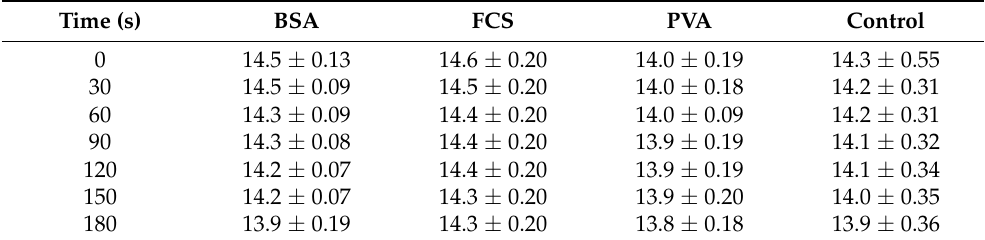
Table 4. The glutathione peroxidase (GPx) enzyme activities (nmol/min/mL) in bovine oocytes matured in media supplemented with BSA, FCS, and PVA at different measurement times.